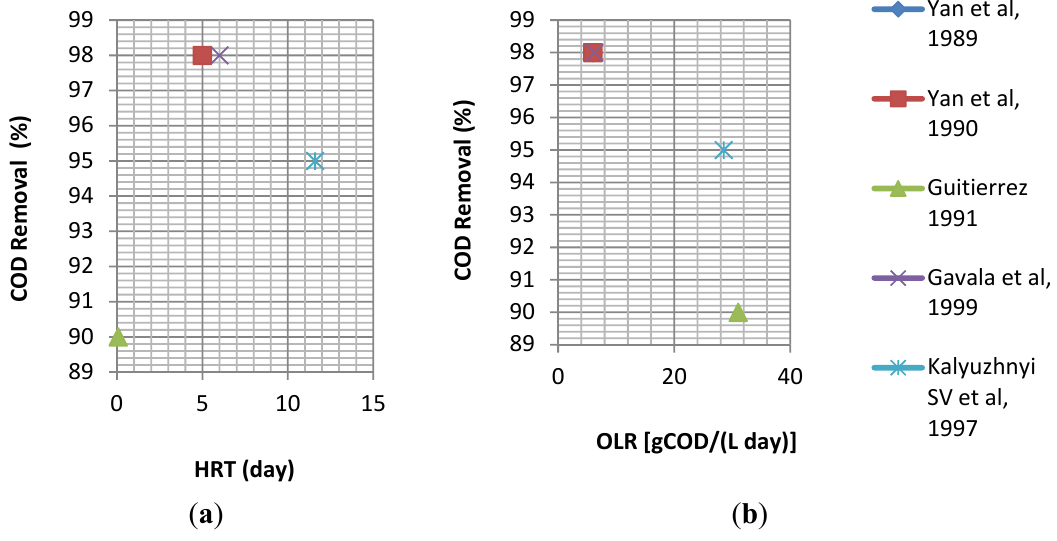
Figure 4. Maximum COD removal versus ( a ) HRT (days) and ( b ) OLR [g COD/(L day)] using UASB reactors for CW